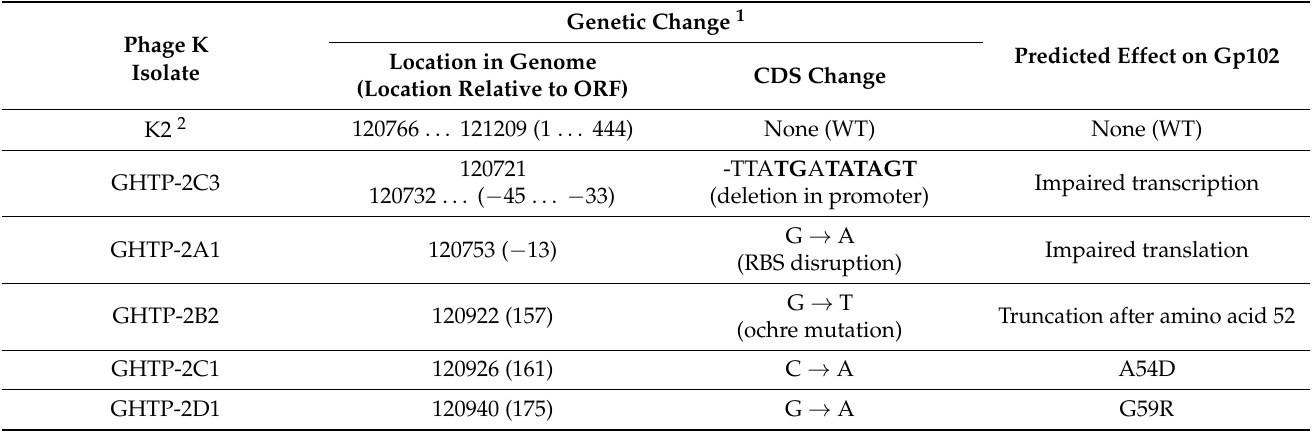
Table 1. Phage K gp102 mutants used for detailed phenotypic